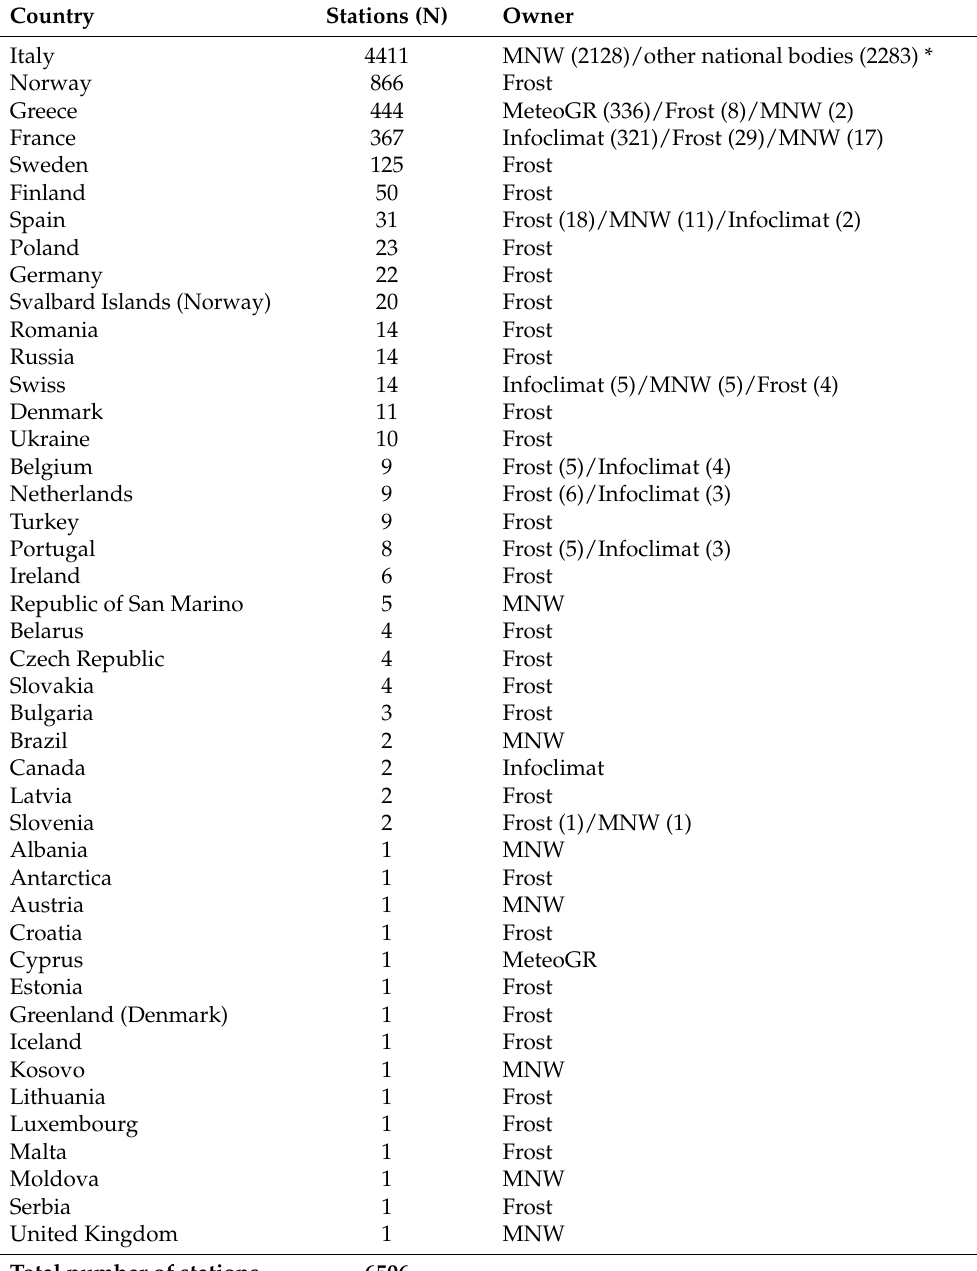
Table 1. Number of operative weather stations in the MWN database.